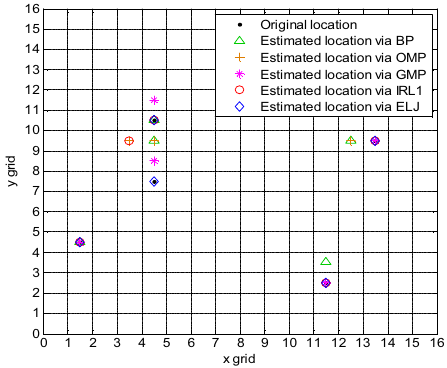
Figure 6. Comparison of target localization for five recovery algorithms.